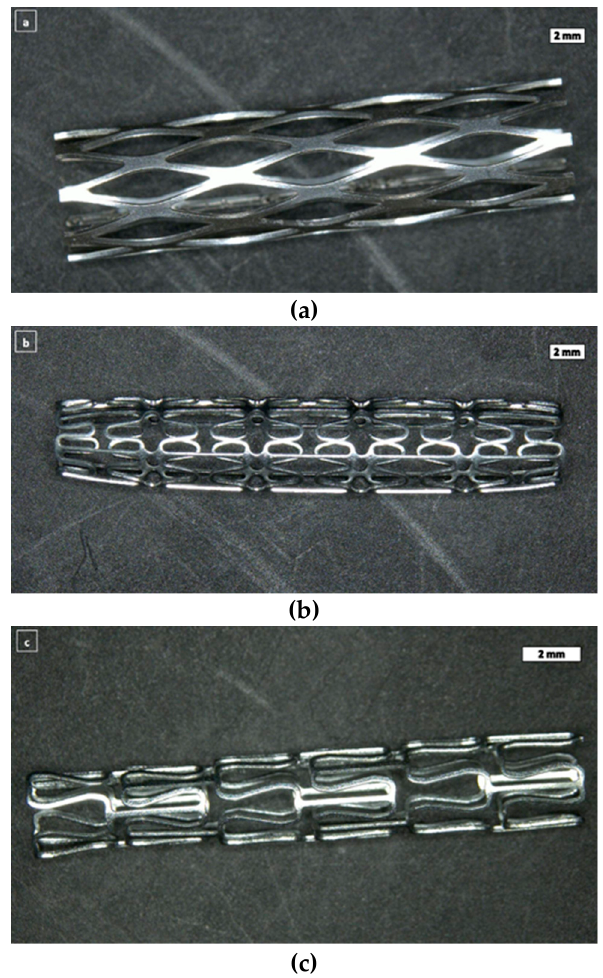
Figure 2. Pictures of Zn stents made by photo-chemical etching with different designs. ( a ) Rhombus design; ( b ) U-design; ( c ) Omega design.